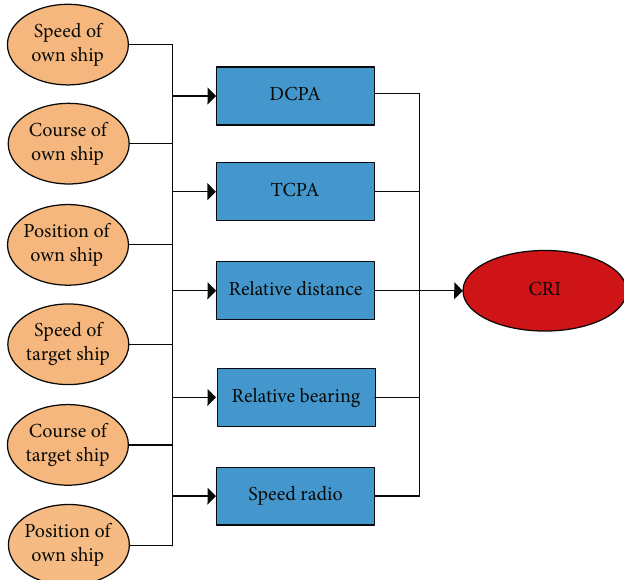
Figure 3: In fl uencing factors of CRI and process of calculation. Table 1: Grade standard and grey cloud whitening weight model for CRI of head-on situation. Risk factors Very